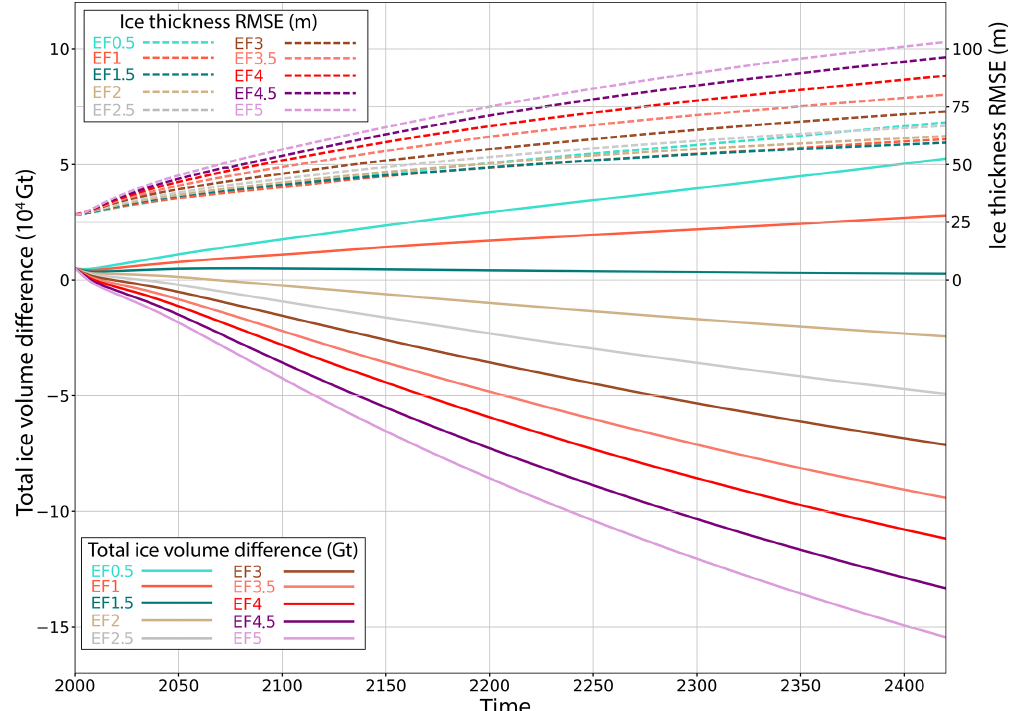
Figure 9. Temporal evolution of GrIS total volume difference in gigatons (solid lines) and RMSE (m; dashed lines) for Nb inv = 20 years and Nb free = 200 years, with varying enhancement factors (Ef) ranging from 0.5 to 5. The Nb cycle chosen here corresponds to the one producing the minimum ice thickness RMSE (see Table